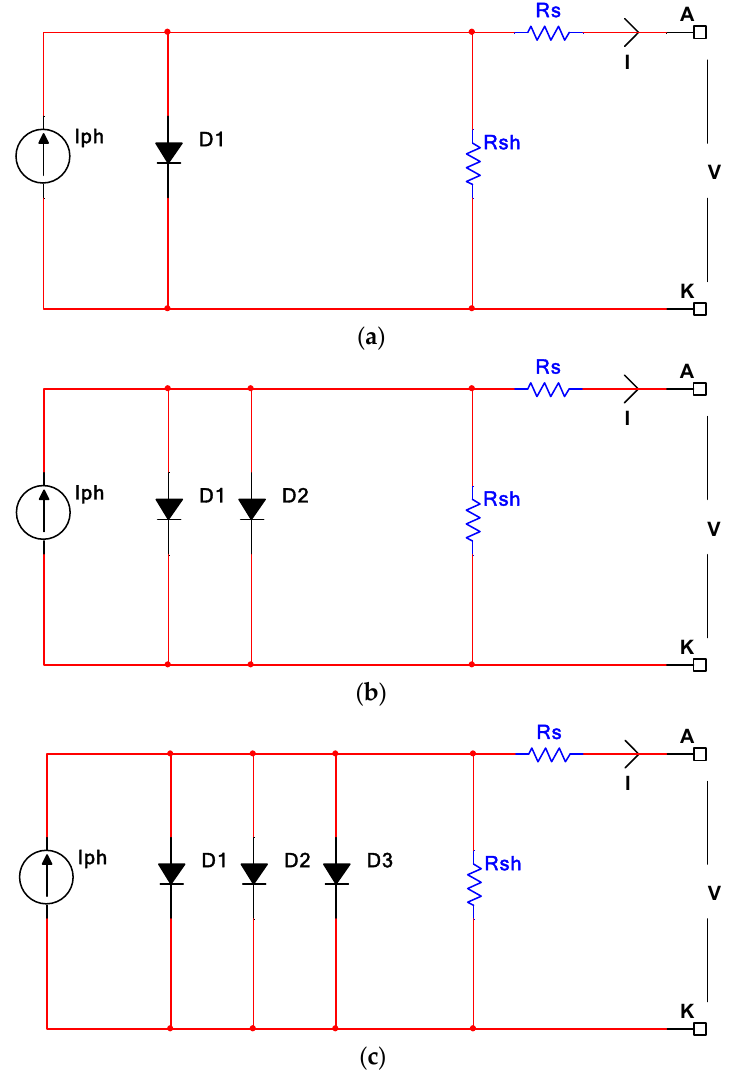
Figure 6. PV models: ( a ) one-diode model; ( b ) two-diode model; ( c ) three-diode model.